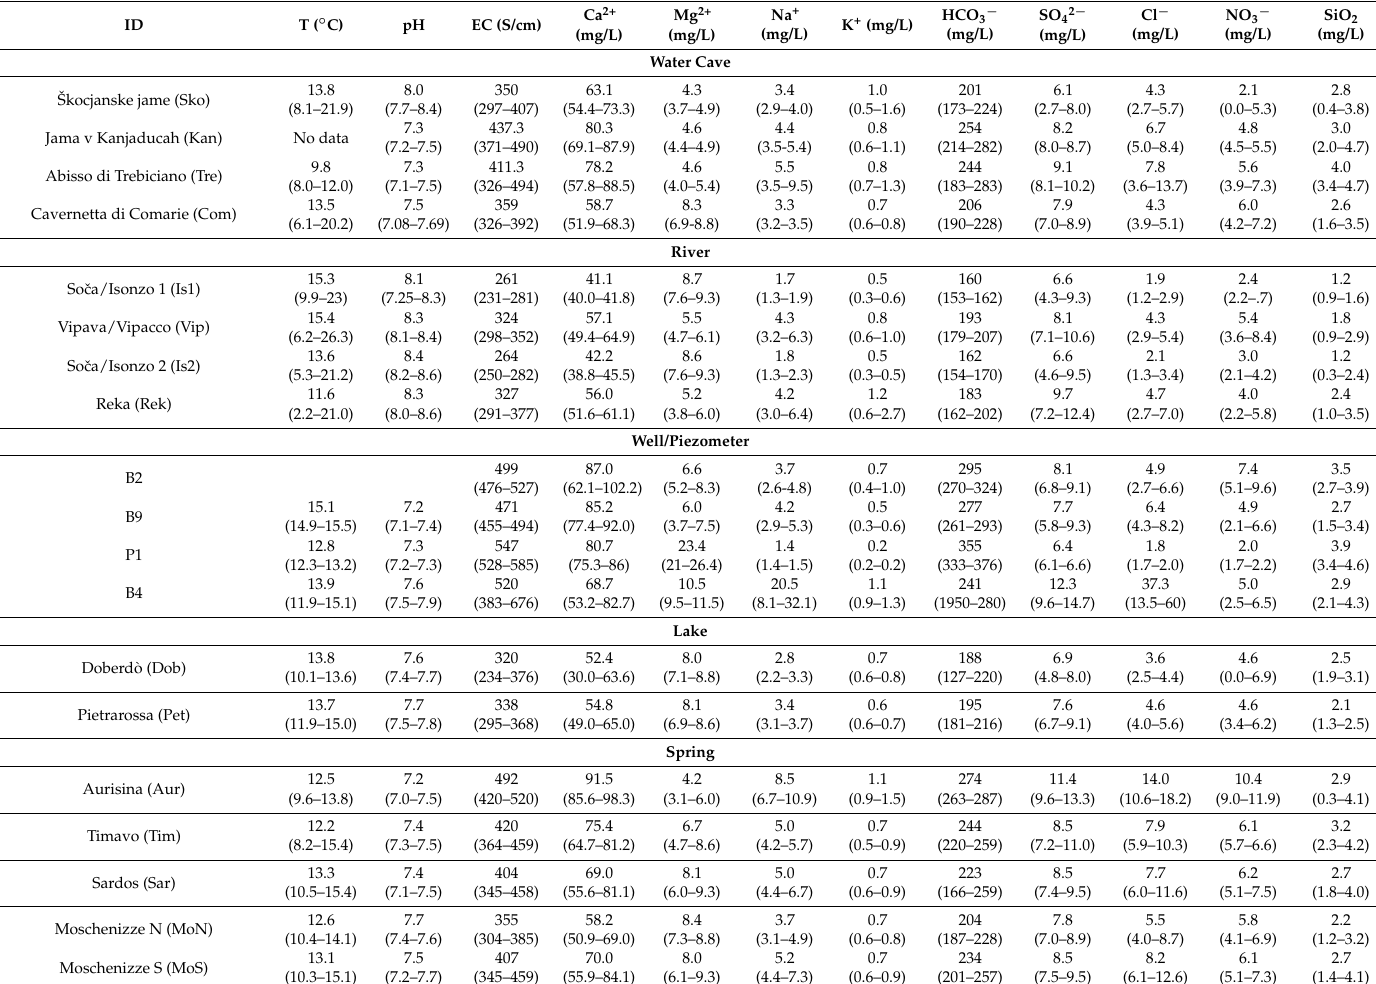
Table 1. Chemical–physical parameters and major ions chemistry with silica content. The numbers represent mean, minimum and maximum value (in parentheses) measured during the sampling